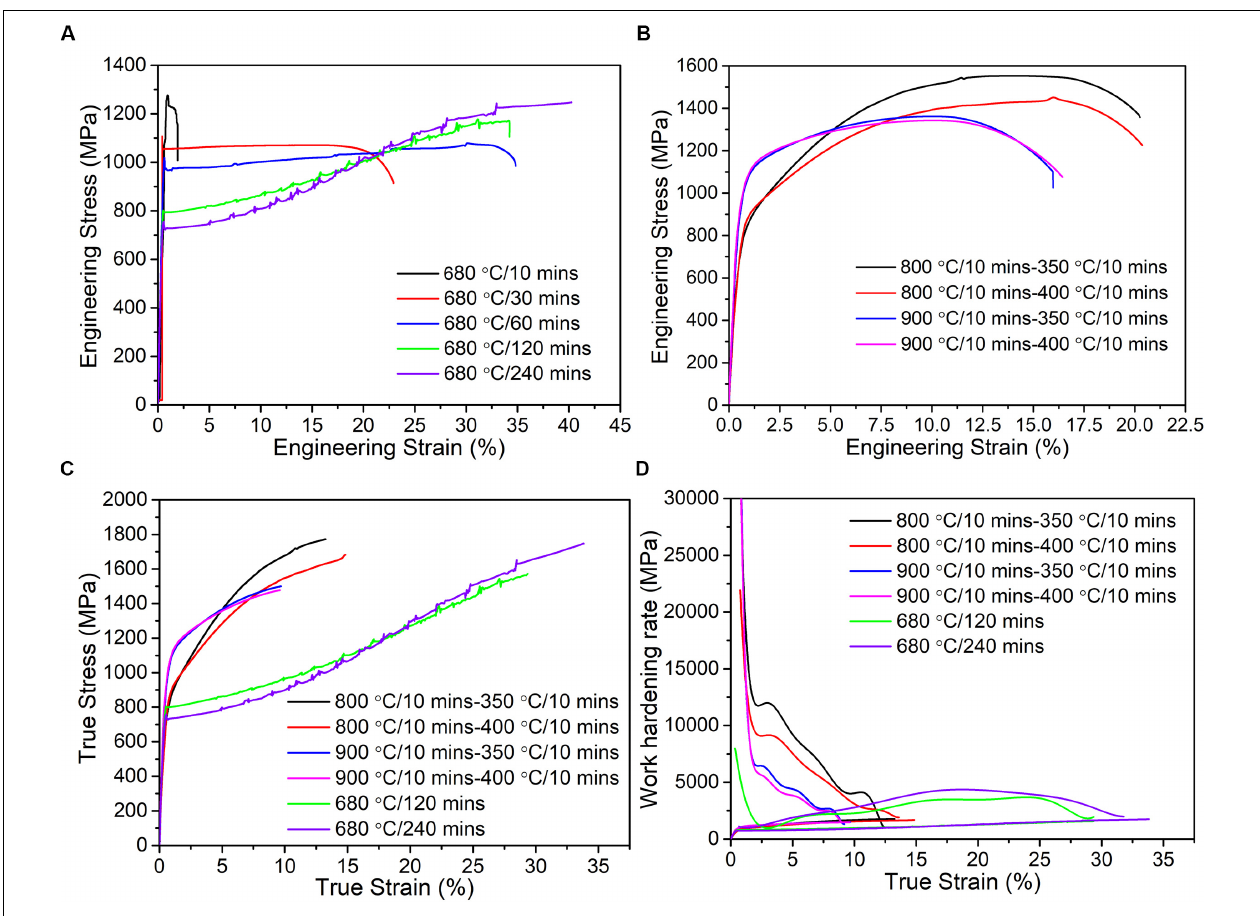
FIGURE 4 | (A) Engineering stress-strain curves of IA steels with different annealing time. (B) Engineering stress-strain curves of IA-Q&P and Q&P steels with different partitioning temperature. (C) True stress-strain curves of IA, IA-Q&P, and Q&P steels. (D) Work hardening rate of IA, IA-Q&P, and Q&P